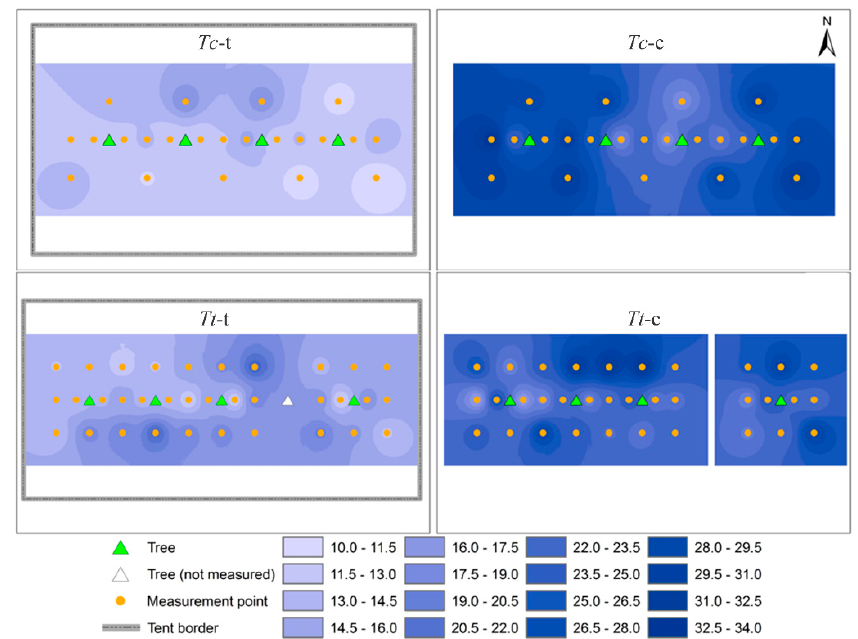
Figure 4. Maps (interpolated values) of the volumetric soil water contents (Vol.-%; VWC) at a soil depth of 10 cm averaged over four measurement days in summer 2017 and collected at defined distances from the study trees. The rooting zones of the tree individuals in the respective left graphics were covered by the rainfall exclusion constructions (‘drought treatment’, Tc -t and Tt -t), whereas the individuals in the right images belonged to the control groups (‘control’, Tc -c and Tt -c).